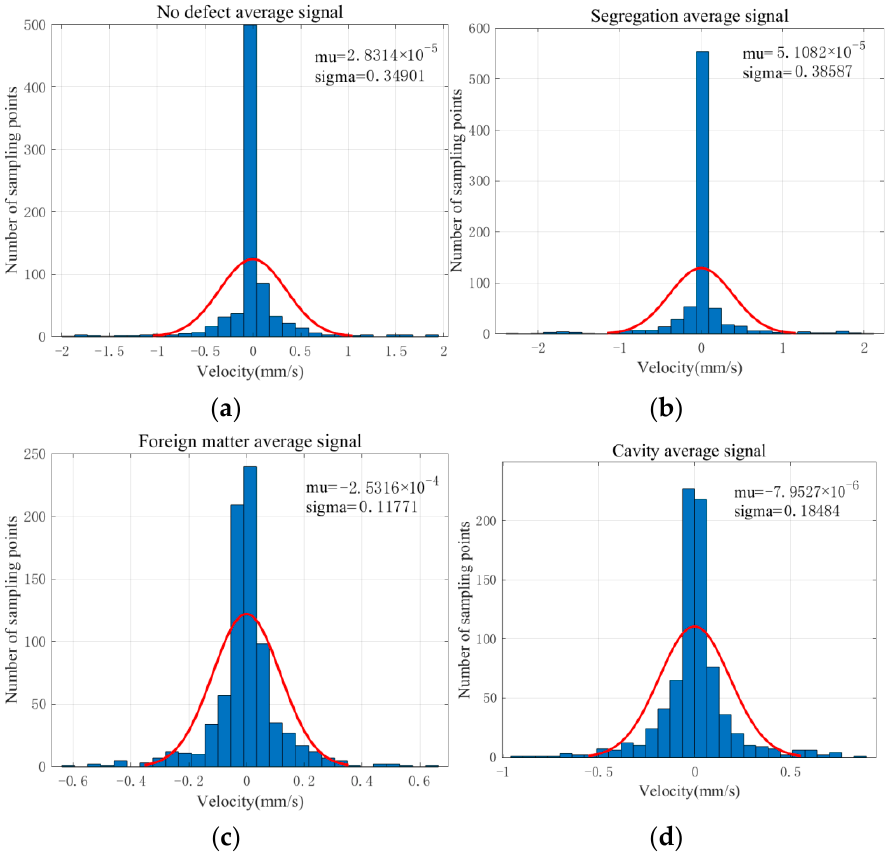
Figure 6. (a) Velocity amplitude histogram of no defect average signal; (b) Velocity amplitude his- Figure 6. ( a ) Velocity amplitude histogram of no defect average signal; ( b ) Velocity amplitude togram of segregation average signal; (c) Velocity amplitude histogram of foreign matter average histogram of segregation average signal; ( c ) Velocity amplitude histogram of foreign matter average signal; (d) Velocity amplitude histogram of cavity average signal. signal; ( d ) Velocity amplitude histogram of cavity average